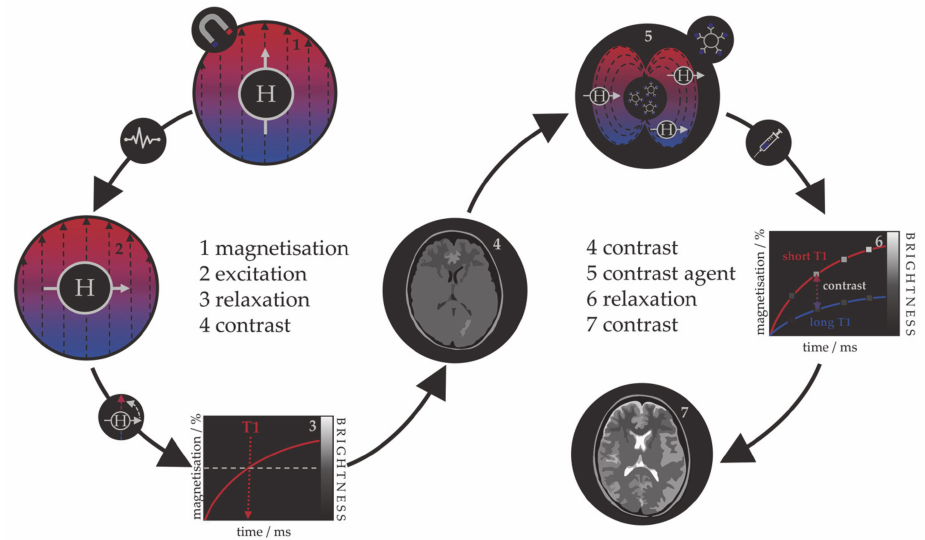
Figure 1. Schematic representation of the principle behind the MRI contrast